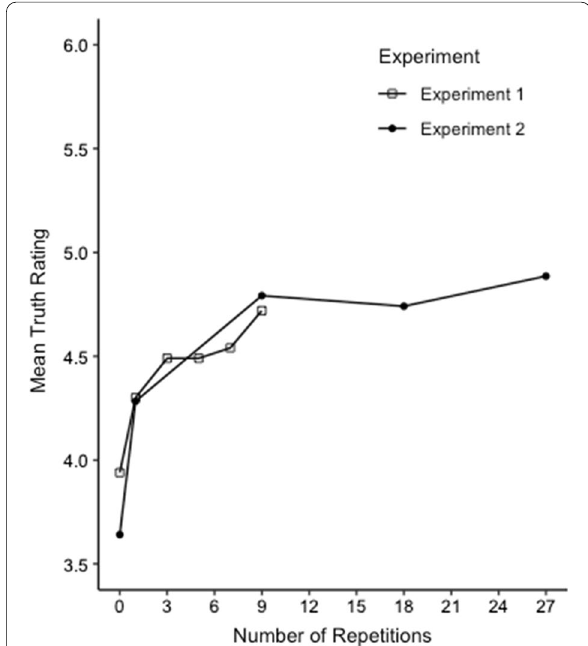
Fig. 1 Mean Truth Ratings as a Function of Number of Repetitions in Experiment 1 and Experiment